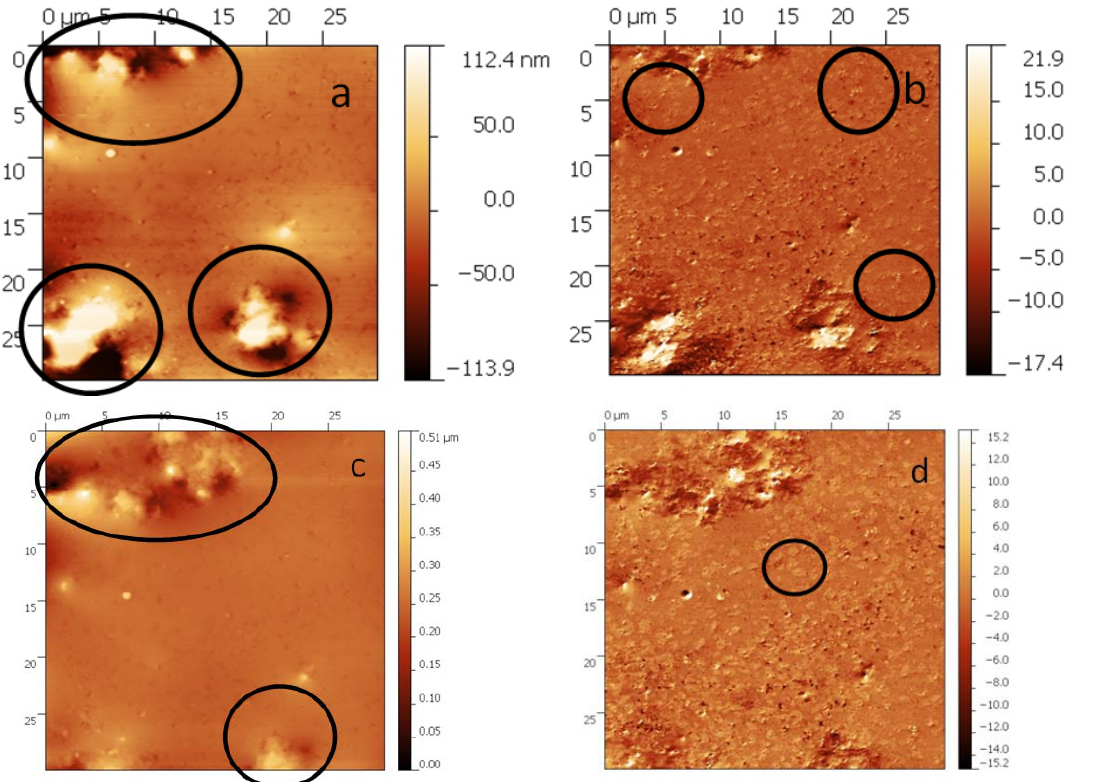
Figure 3 . Height (a,c) and phase (b, d) contrast pictures as recorded by AFM of the asphalt sample under investigation (AFM imaging procedures are descibed in [5 ‐ 11]. The height images show the presence of filler particles (encircled). The phase contrast images show clearly the presence of two phases within the binder (peri and perpatua phase) and especially the crystallites and bee ‐ like features (encircled) within the peri phase